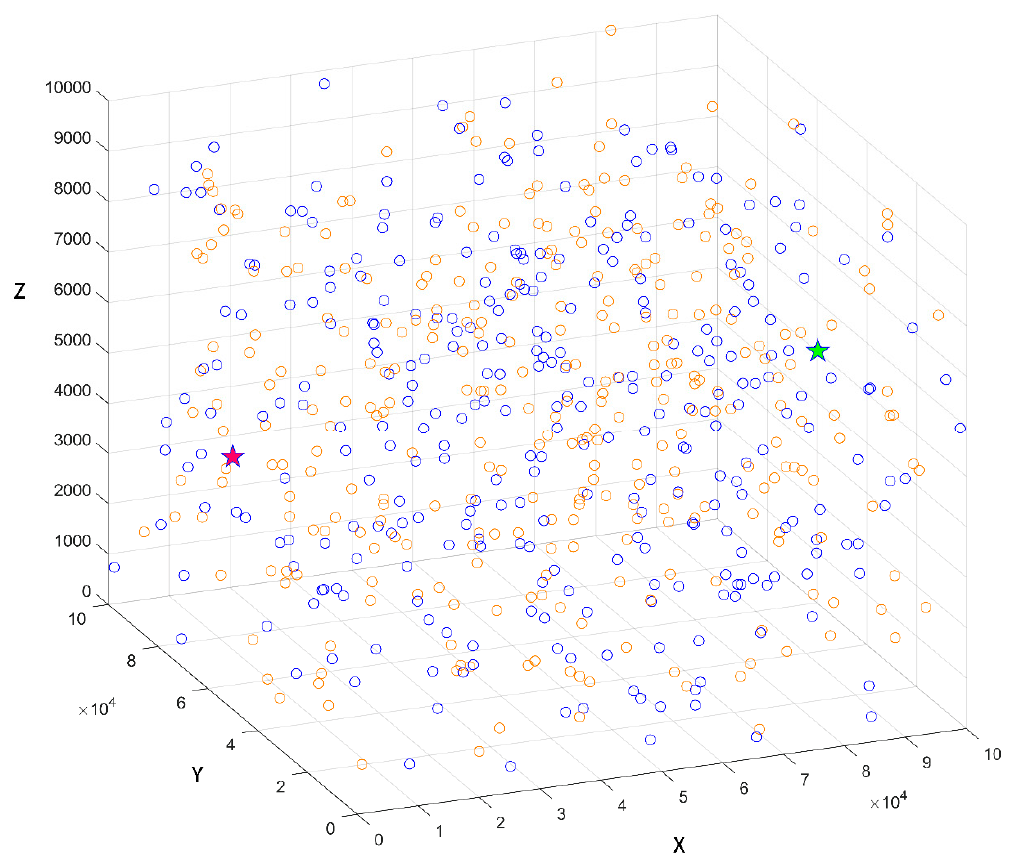
Figure 2. The physical space and the correct point. The blue point is the vertical error correction point, the yellow point is the horizontal error correction point, the red pentagram indicates starting point, the green pentagram indicates ending points. The range of axes comes from the data set.